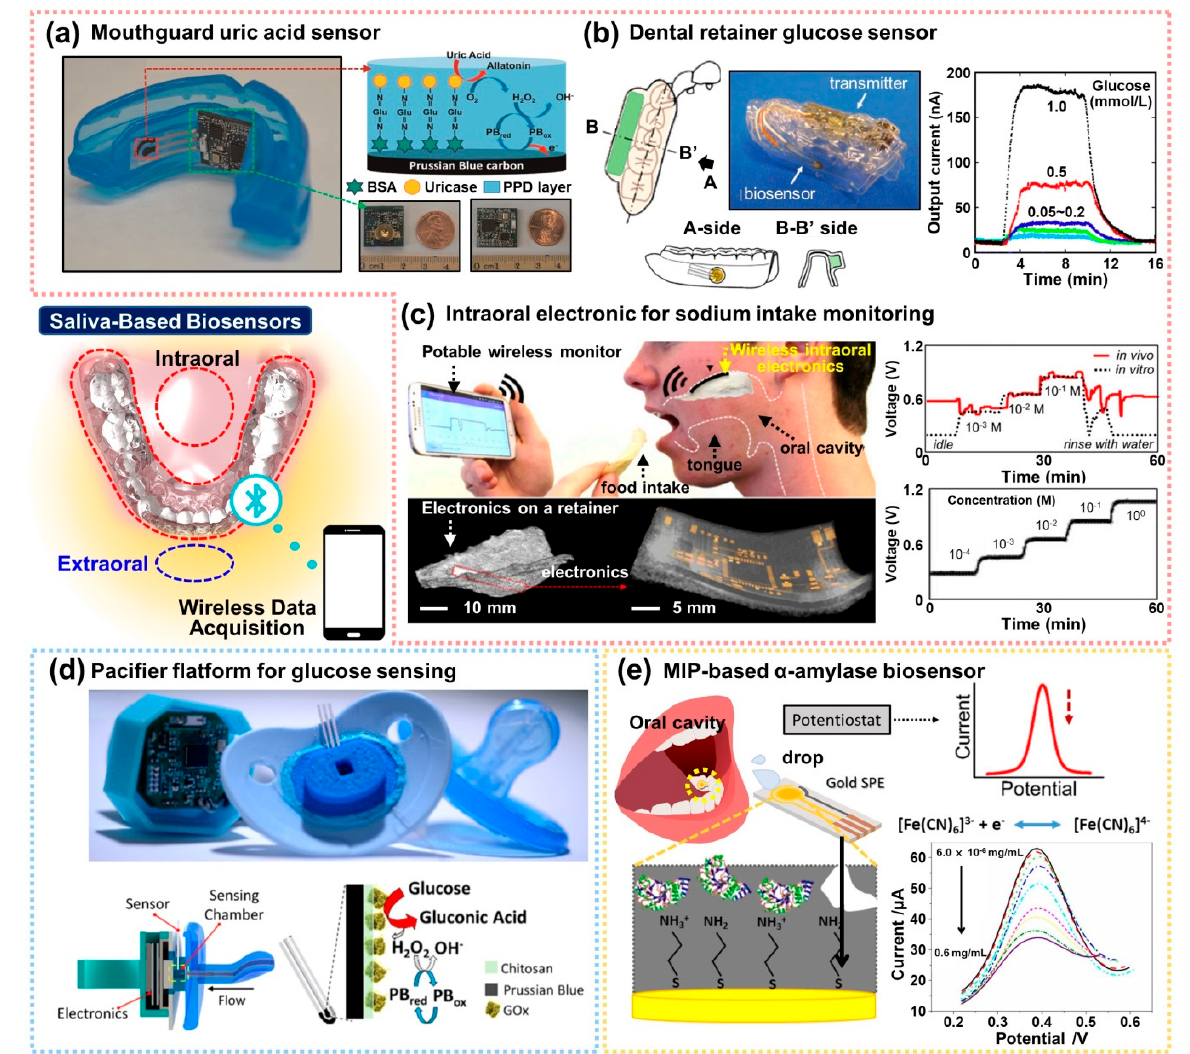
Figure 7. Concept of non-invasive biosensing platforms mounted in the oral cavity for real-time monitoring by wireless communication to detect molecules (middle left image). ( a ) A mouthguard integrated with a wireless circuit board for monitoring salivary UA and the chemically modified SPE sensor for electrochemical detection. Reproduced with permission from [150]. Copyright Elsevier, 2015. ( b ) Customized glucose biosensor mounted on a plastic retainer with a detection range of 0.05–1.0 mM L − 1 in artificial saliva. Reproduced with permission from [153]. Copyright Elsevier, 2016. ( c ) A wireless electronic device mounted on a retainer with a permeable porous membrane that detects sodium ions. The graphs show clear changes in the electrical signals according to sodium concentration based on in vitro and in vivo experiments. Reproduced with permission from [155]. Copyright National academy of sciences, 2018. ( d ) A pacifier-type glucose biosensor for external monitoring of saliva collected without any pump through the fluidic channel. Reproduced with permission from [158]. Copyright American Chemical Society, 2019. ( e ) Scheme of α -amylase imprinted biosensing platform on Au-SPE electrode to quantify the concentration range of 6.0 × 10 − 6 –0.6 mg mL − 1 through the electrochemical method. Reproduced with permission from [83].